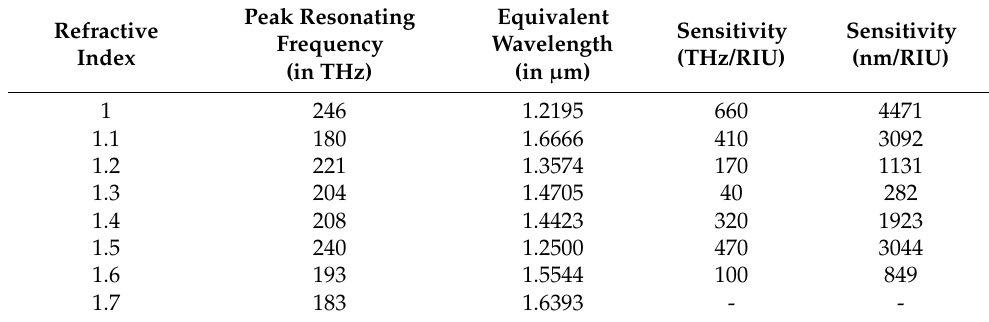
Figure 11. Calculated FOM at the different frequencies for the different refractive indices of an analyte. Table 1. Peak resonating frequency and its respective sensitivity values. Table 2. Comparison of the proposed structure with the already existing structure.